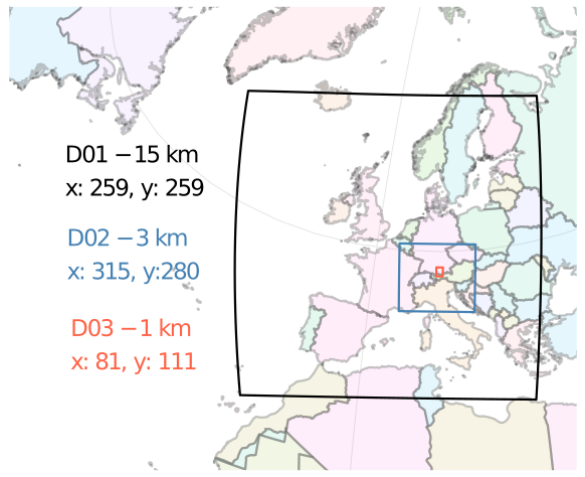
Figure 3. Domain nesting configuration for WRF_SA and WRF- H_FC simulations.